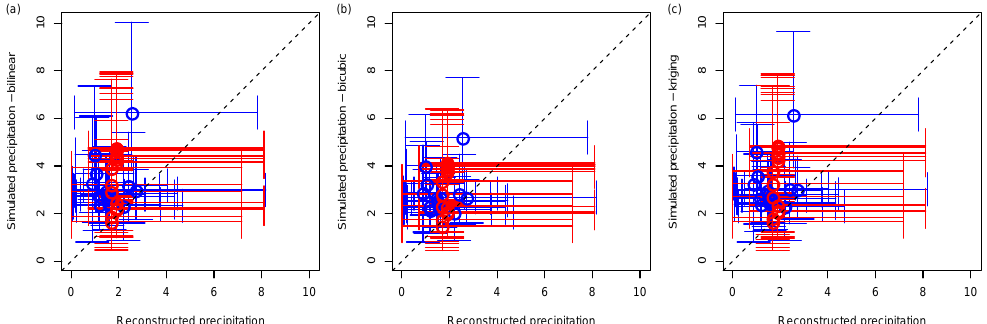
Figure 8. Boxplot of reconstructed vs. downscaled precipitation for the LGM based on the BCI indices (red), and from Wu et al. (2007)’s reconstructions (blue) for (a) the bilinear, (b) the bicubic and (c) the kriging interpolations. The circles represent the mean temperature values for the two reconstruction methods ( x axis) and the downscaled values over the 50 simulated years ( y axis). The horizontal error bars represent the range of precipitation values for the reconstruction method (minimum and maximum over the whole zonobiome for the BCI indices; mean precipitation of the coldest and warmest months for Wu et al., 2007). The vertical error bars correspond to the mean precipitation of the driest and wettest months over the 50 simulated